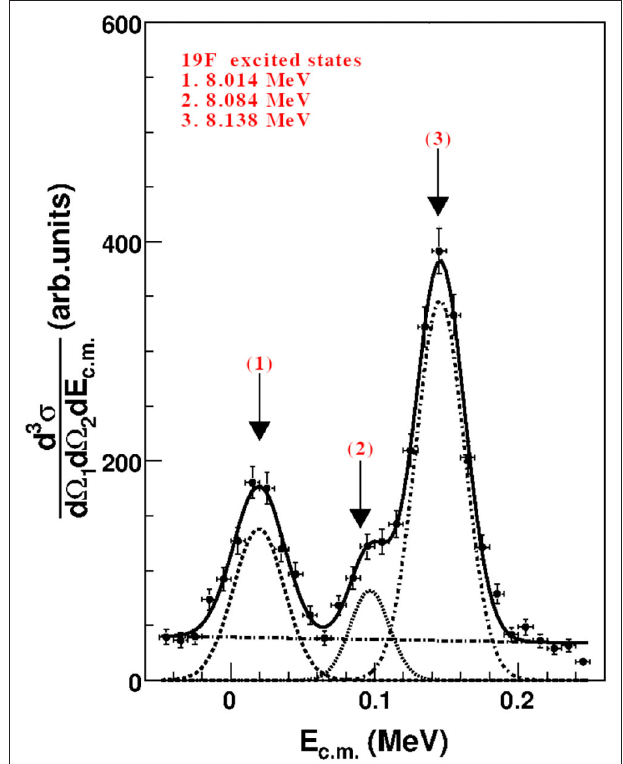
FIGURE 6 | Cross section of the 2 H( 18 O, α 15 N) n TH reaction. See text for